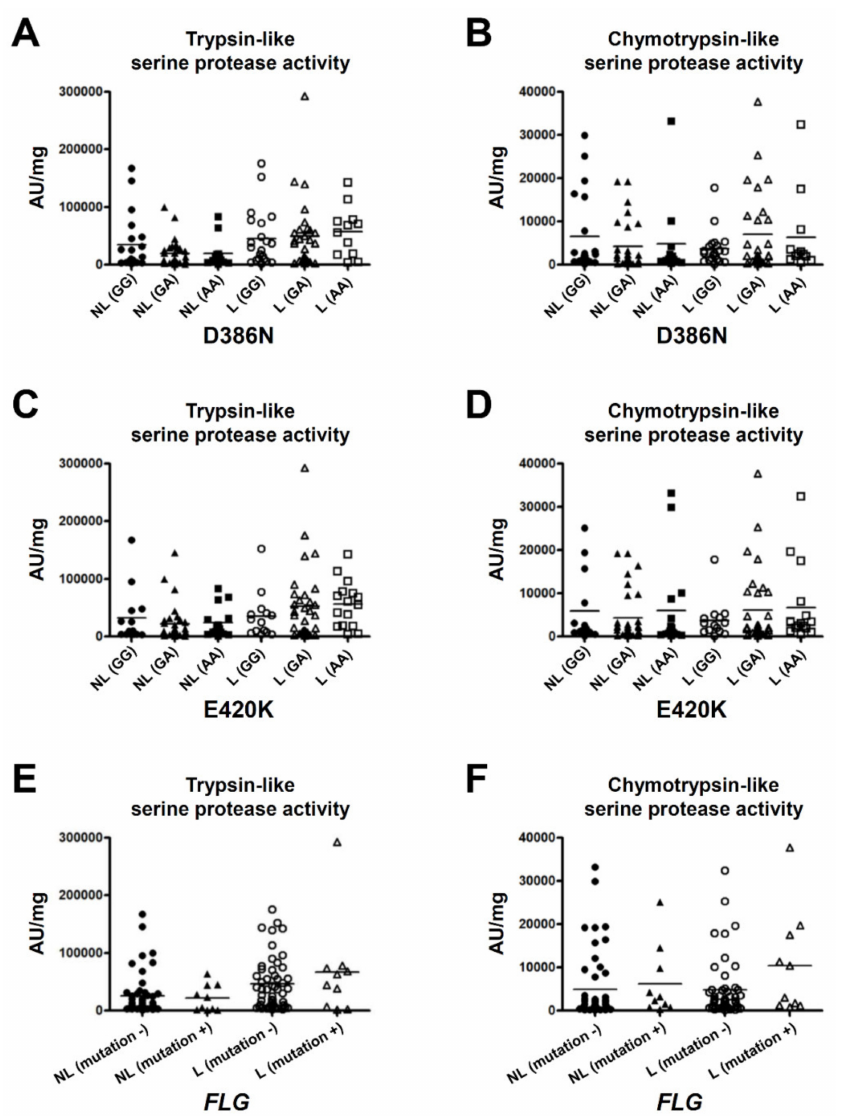
Figure 4. Serine protease activity in the SC of the subgroups of patients with the variants of the SPINK5 gene and FLG gene in AD patients. Trypsin- and chymotrypsin-like serine protease activity in non-lesions and lesions was compared among the subgroups of the p.D386N ( A – B ) or p.E420K ( C – D ) of SPINK5 and among the subgroups with or without loss-of-function mutations of FLG ( E – F